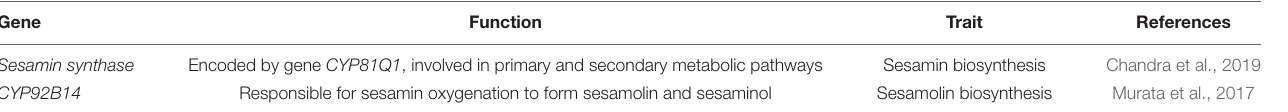
TABLE 5 | Genes involved in lignin biosynthesis in